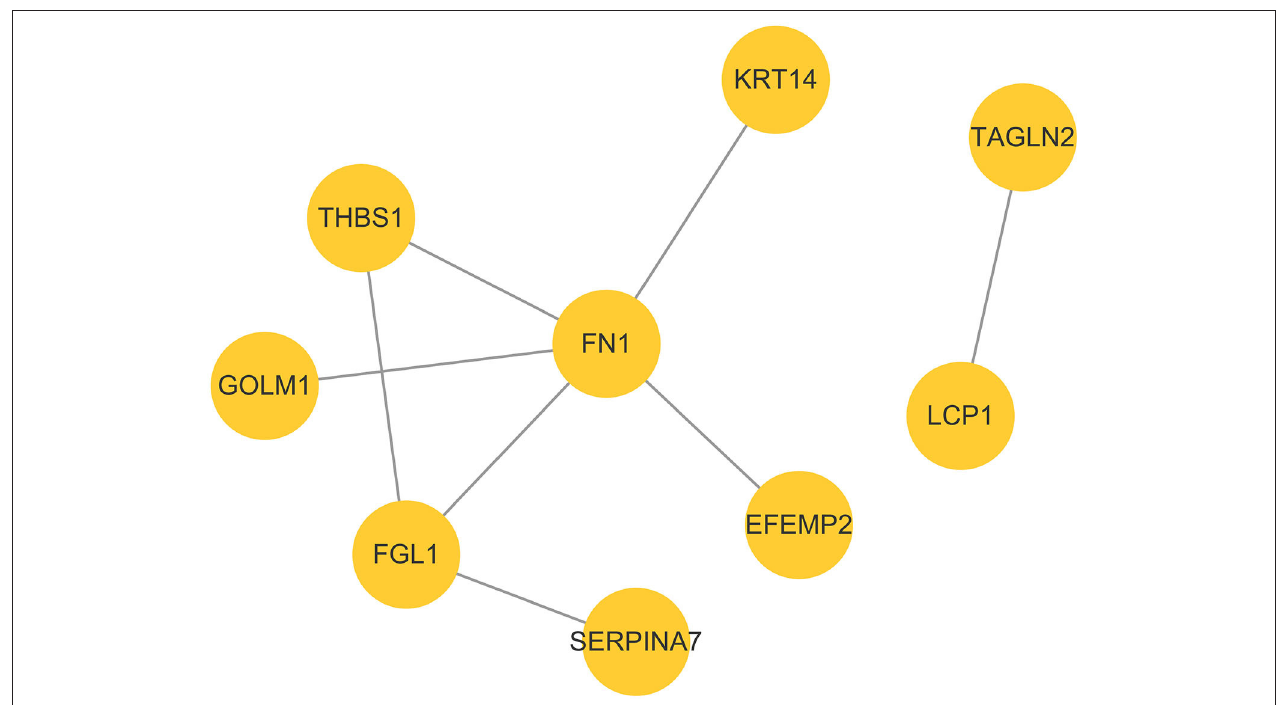
FIGURE 5 | Protein–protein interaction network analysis based on DEPs in the P group vs. the NP